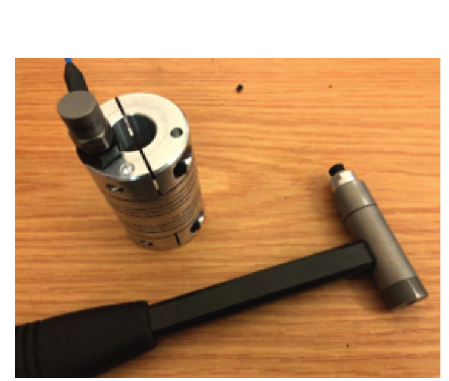
Figure 7: Experimental procedure used to find the coupling’s damping values.